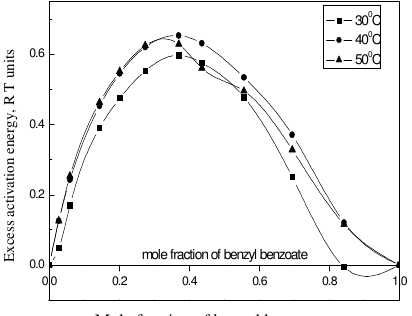
Mole fraction of benzyl benzoate Figure 1e. Variation of excess activation Figure 1f. Variation of excess viscosity with energy with mole fraction of benzyl mole fraction of benzyl benzoate in the benzoate in the mixture benzyl benzoate mixture benzyl benzoate +